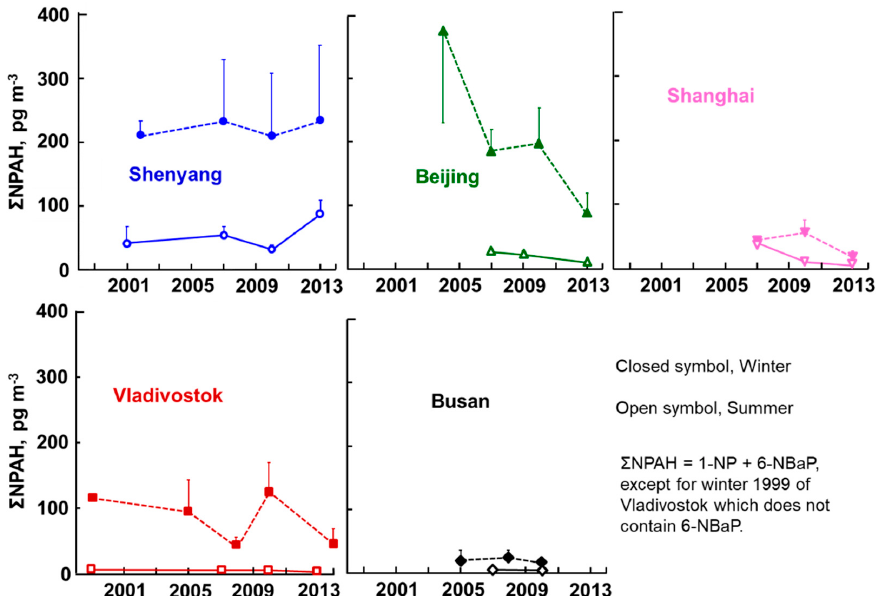
Figure 3. Atmospheric total nitropolycyclic aromatic hydrocarbon ( Σ NPAH) concentrations.